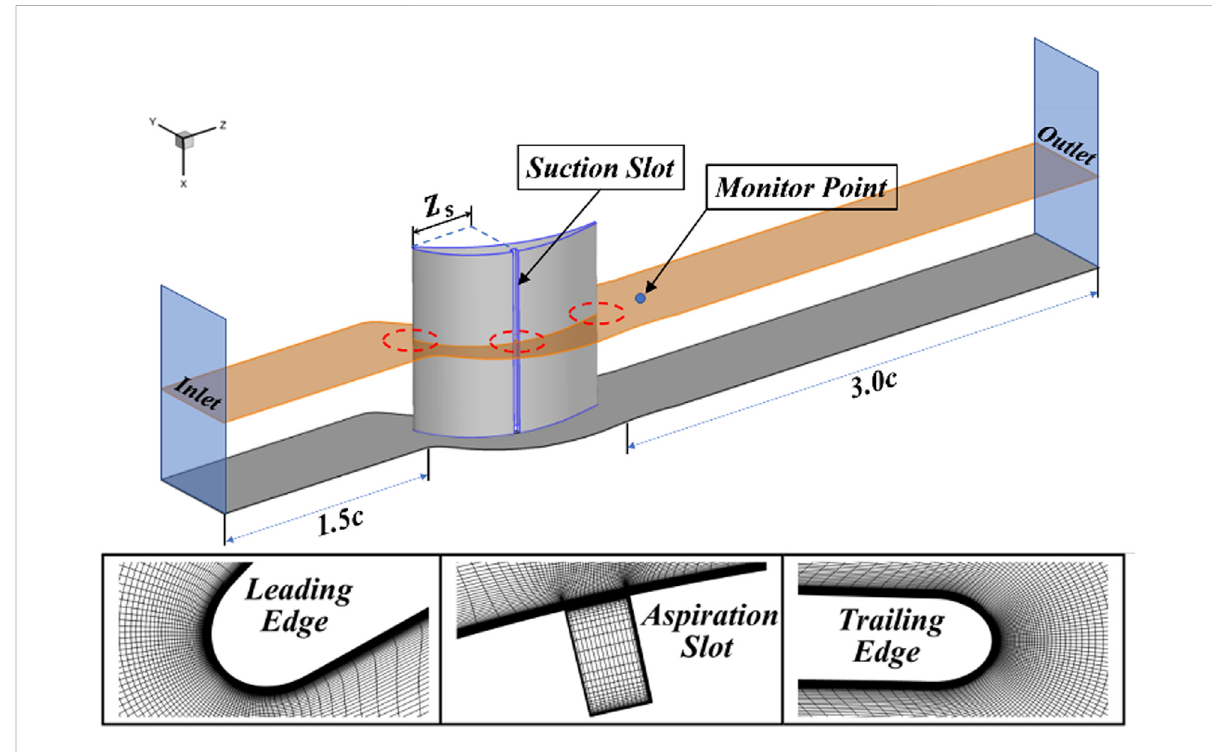
FIGURE 1 Schematic of blade geometry and computational domain.